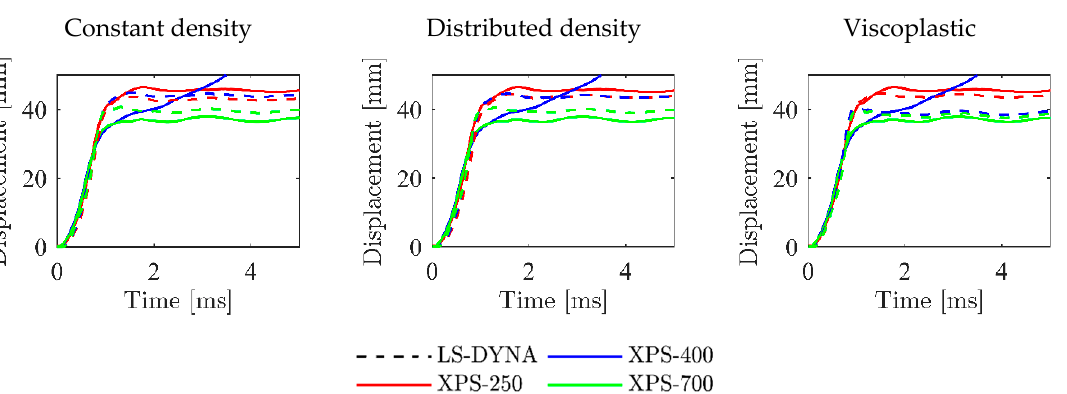
Figure A10. Comparison between experimental and numerical midpoint displacements for tests with 15 bar firing pressure.